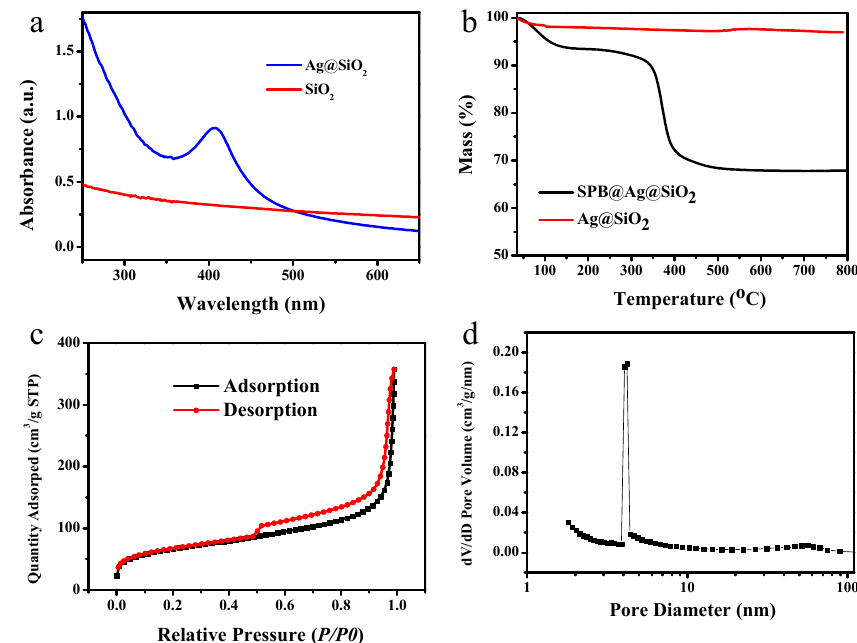
Figure 4. ( a ) UV-vis absorption spectra of hollow SiO 2 and hollow Ag@SiO 2 ; ( b ) TGA curves of SPB@Ag@SiO 2 and hollow Ag@SiO 2 ; ( c ) N 2 adsorption and desorption isotherms of hollow Ag@SiO 2 nanoparticles; ( d ) the corresponding pore size distribution calculated by the BJH method.